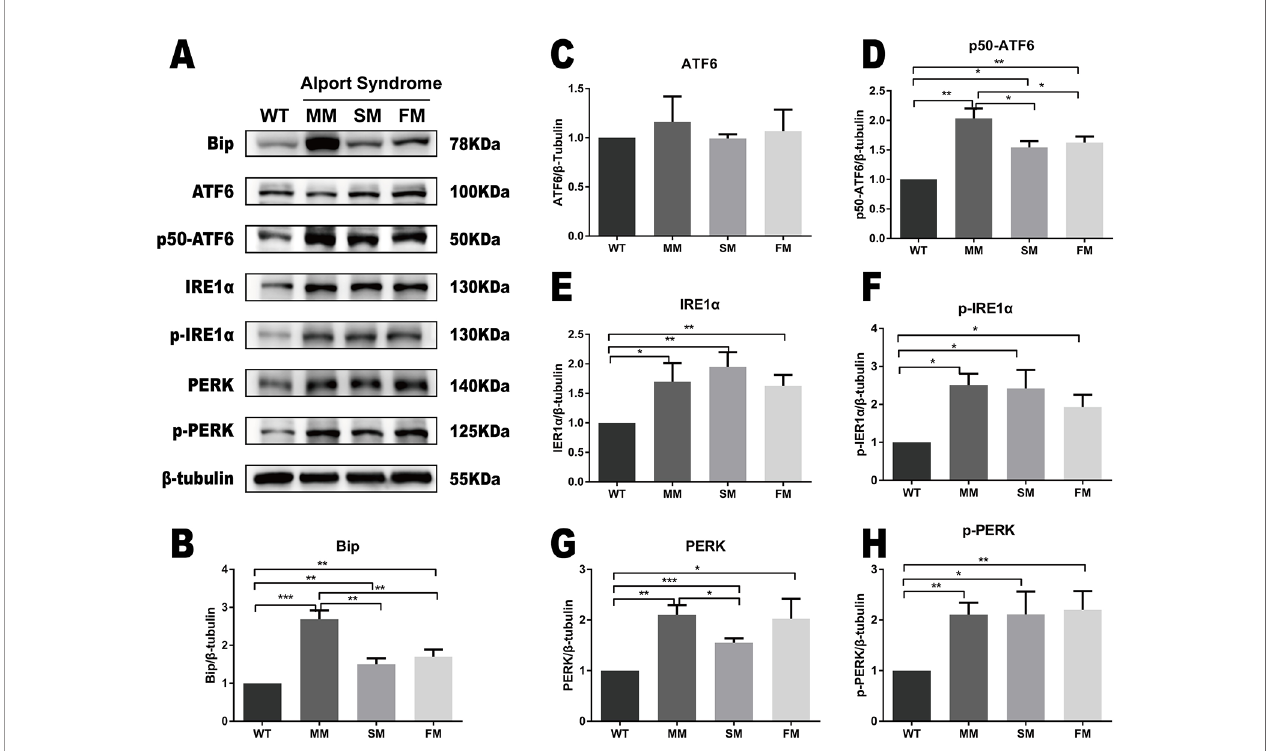
FIGURE 4 | ERS pathway was activated in COL4A5 mutant fi broblasts. (A) Protein expression of the ER stress markers Bip, ATF6, p50-ATF6, IRE1 a , p-IRE1 a , PERK, and p-PERK. b -tubulin was used as an equal loading control ( Supplementary Figure 2 ). (B – H) Representative densitometric analysis of western blots of these proteins. Data are means ± SEM. n = 3 (* p < 0.05; ** p < 0.01; *** p < 0.001; WT, control; MM, missense mutation; SM, splicing mutation; FM, frameshift mutation).